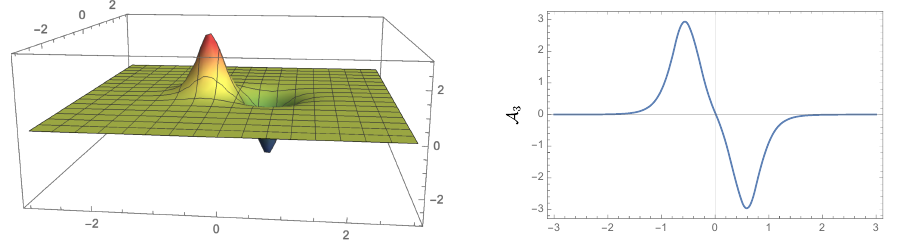
Figure 7 . Density of the topological charge A 3 of U(1) a of the vortex molecule solution. Left-panel shows 3D plot, and the right-panel shows its slice at y = 0 . The model parameters are the same as those in figure 5. The length unit is taken so that v (= 123 GeV) = 1 . The integrated value of A 3 over a half-plane x < 0 ( x > 0 ) is ± 0 . 4762 ,